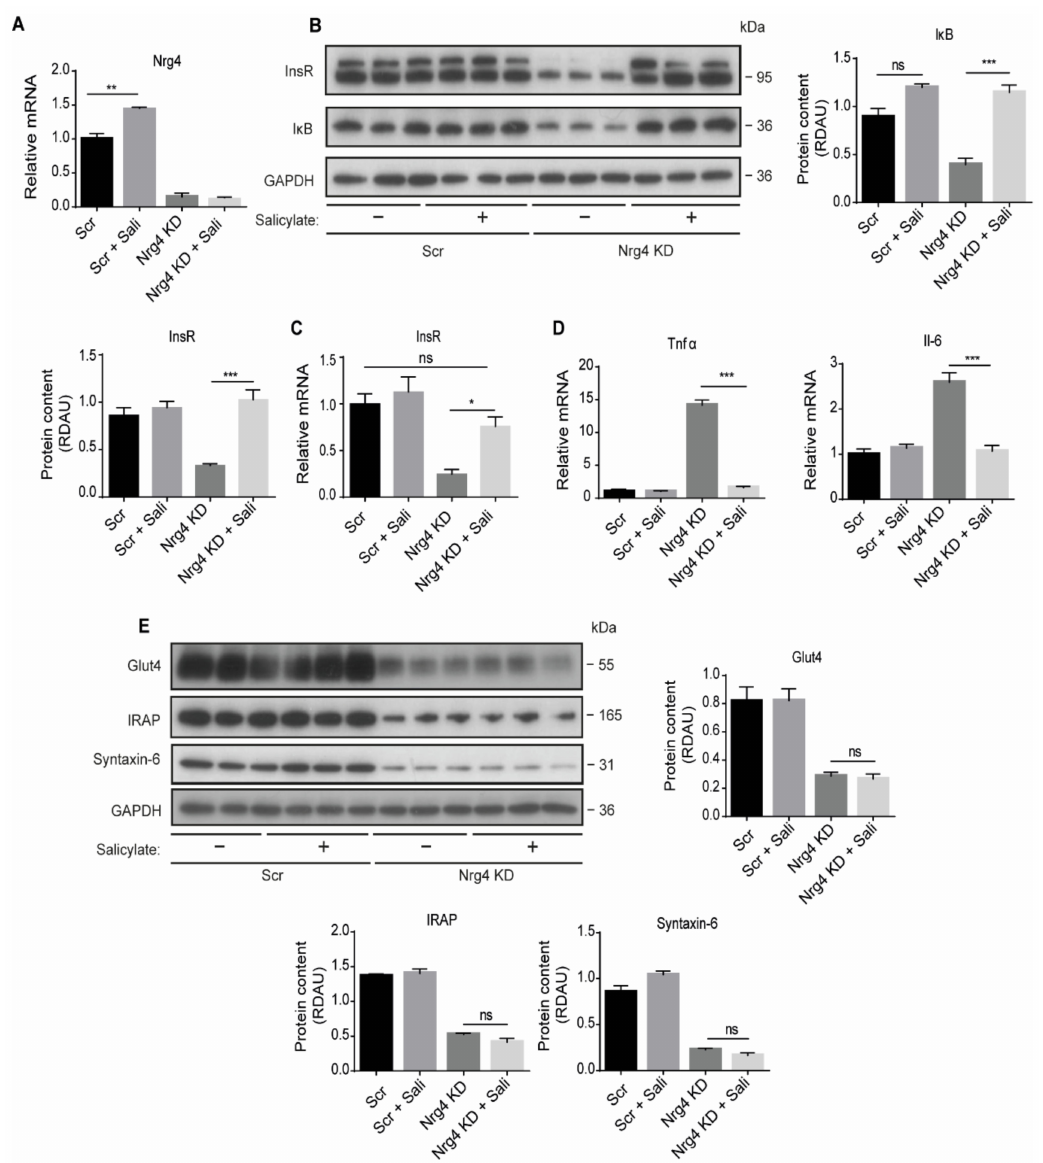
Figure 5. Salicylate treatment reverses the cell-autonomous inflammatory phenotype upon Nrg4 loss-of-function: Adipocytes were treated with 1 mM salicylate (Sali) at D6 for 24 h. ( A ) Nrg4 expression in Sali-treated or non-treated Scr and Nrg4 KD adipocytes at day 7 (D7) of differentiation ( n = 3). ( B ) Western blot bands and quantification of InsR β subunit (quantification of the lower band) and I κ B protein in Sali-treated or non-treated Scr and Nrg4 KD adipocytes at D7 ( n = 3). ( C ) InsR expression in Sali-treated or non-treated Scr and Nrg4 KD adipocytes at D7 ( n = 3). ( D ) Tnf α and Il-6 expression in Sali-treated or non-treated Scr and Nrg4 KD adipocytes at D7 ( n = 3). All the qPCR data were normalized to non-treated Scr adipocyte expression at D7. ( E ) Western blot bands and quantification of Glut4, IRAP and Syntaxin-6 protein in Sali-treated or non-treated Scr and Nrg4 KD adipocytes at D7 ( n = 3). In the western blots, GAPDH was used as a loading control. Each lane of the blots represents an independent experiment. Overall contrast and brightness of the western blots were adjusted to clarify the images. Data represent mean ± SEM. * p ≤ 0.05, ** p ≤ 0.01, *** p ≤ 0.001, ns (not